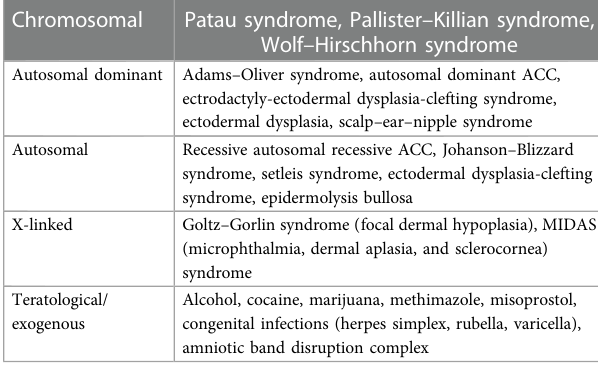
amniotic band disruption